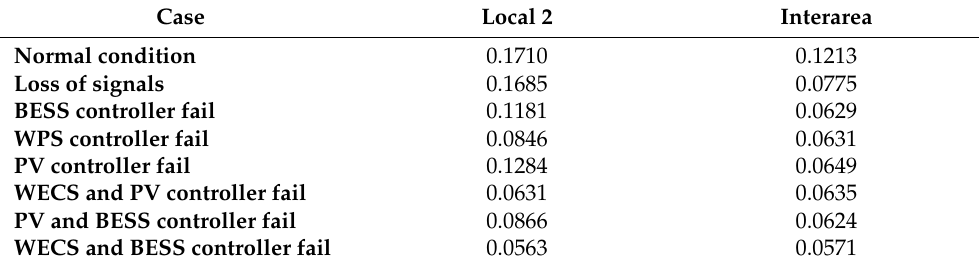
Table 3. Resilient test results.